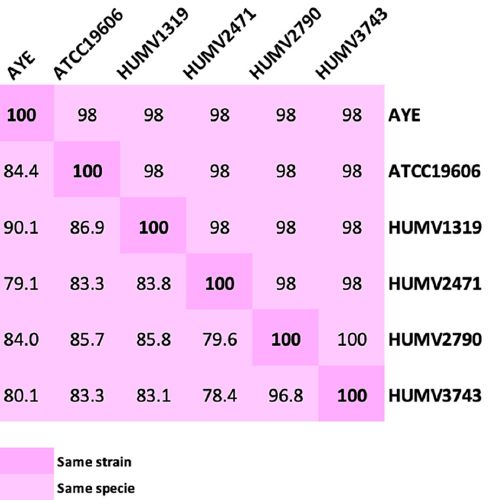
Figure 2. Matrix distance values among A. baumannii strains. The upper part shows ANI values; the lower part, DDH values. An AYE reference strain was also included to confirm the bacterial species.